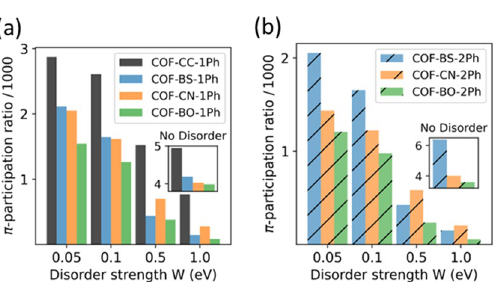
Figure 12. Participation ratio of π -states for different strength of Anderson disorders in a supercell. Calculations without disorder are shown in the inset for the same